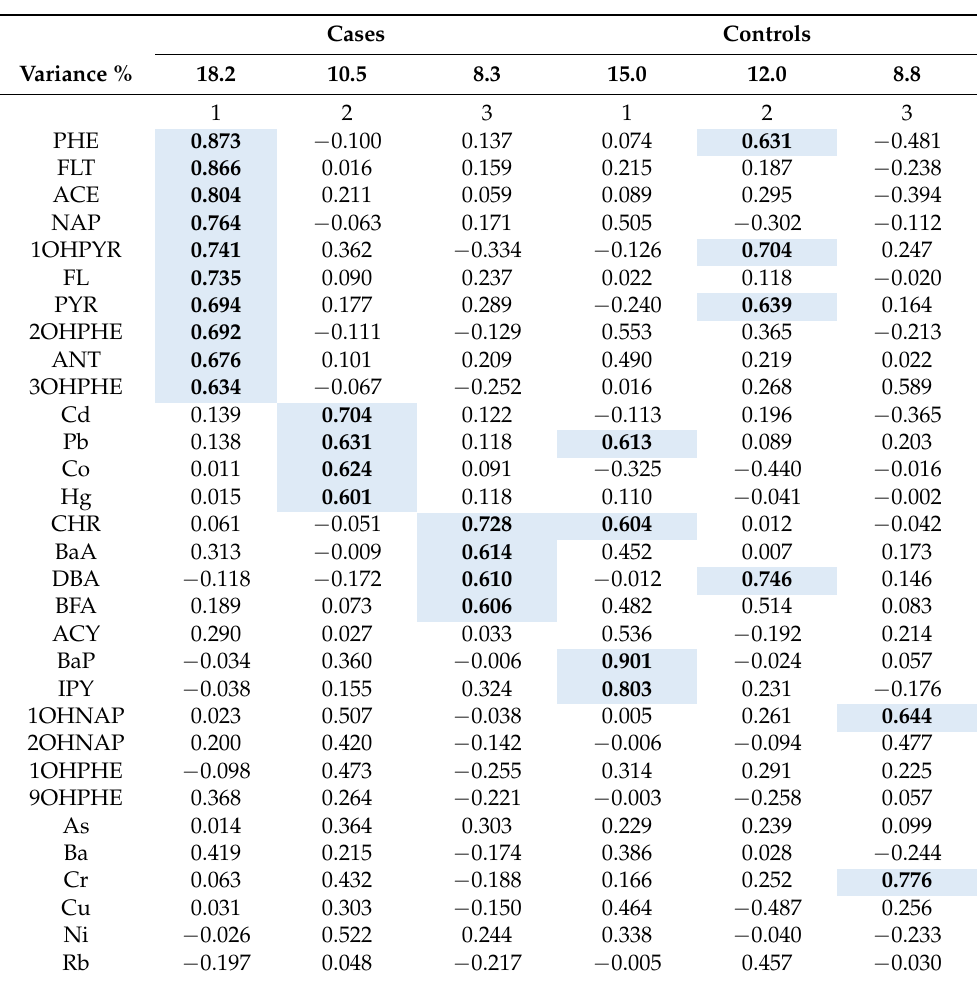
Table 1. Varimax rotated PCA for PAHs, OHPAHs, and trace elements for cases’ and controls’ samples. (Loadings > 0.600 appeared in